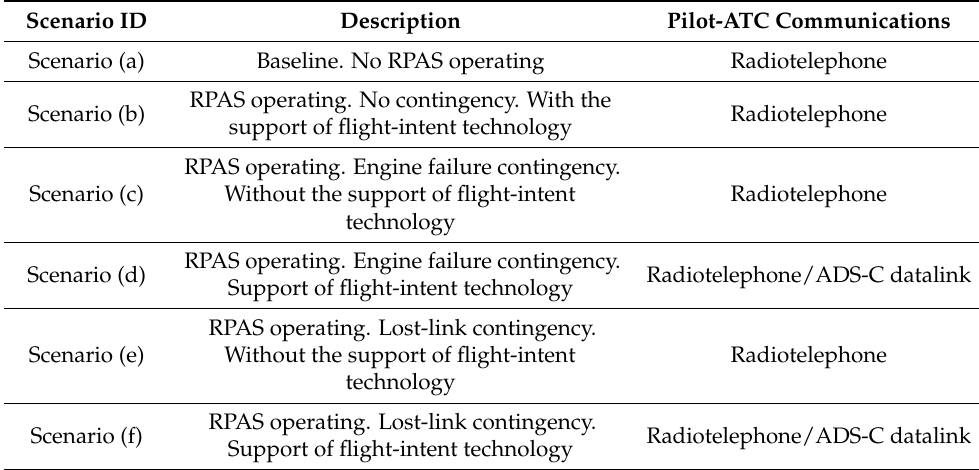
Table 4. Communication technologies per